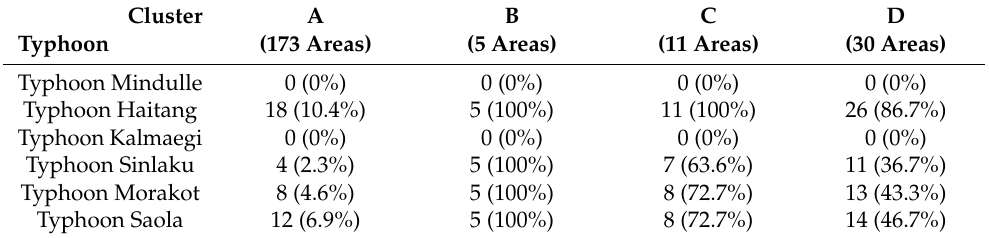
Table 22. Number and percentage of damaged areas per cluster, by typhoon event.